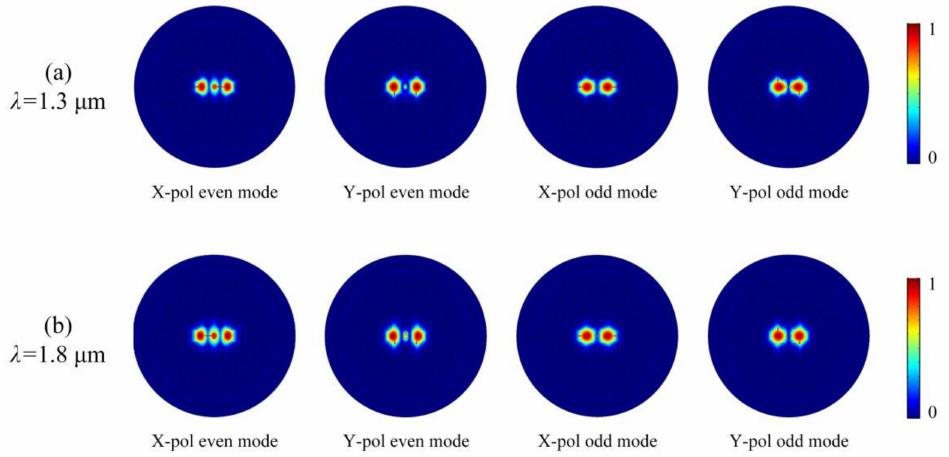
Figure 4. The mode field distribution of the X-pol and Y-pol even and odd modes at ( a ) 1.3 µ m and ( b ) 1.8 µ m when the LC-DC-PCF is filled with LC